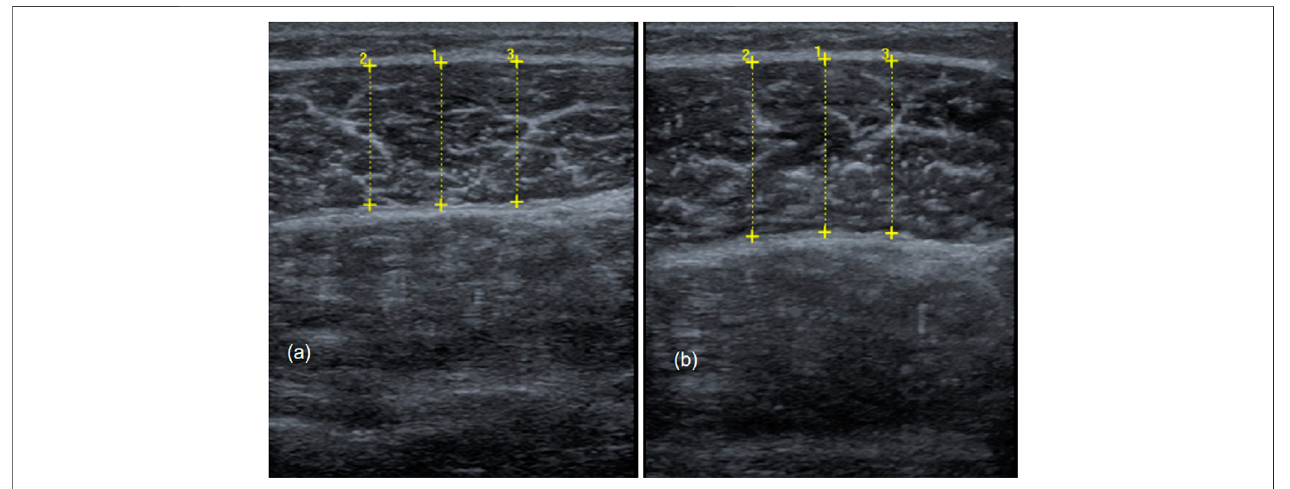
FIGURE 7 | Comparison of muscle thickness from pre-to posttest in the non-stretched control leg (A) and the intervened leg (B) .